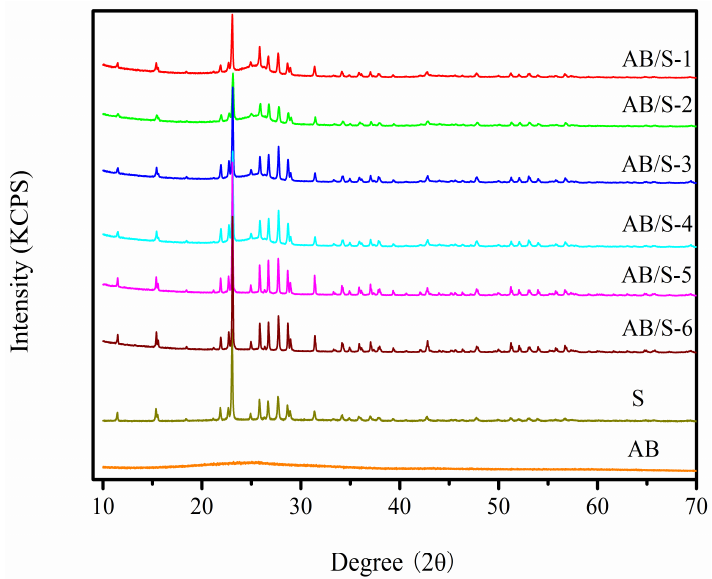
Figure 1. XRD patterns of the composite